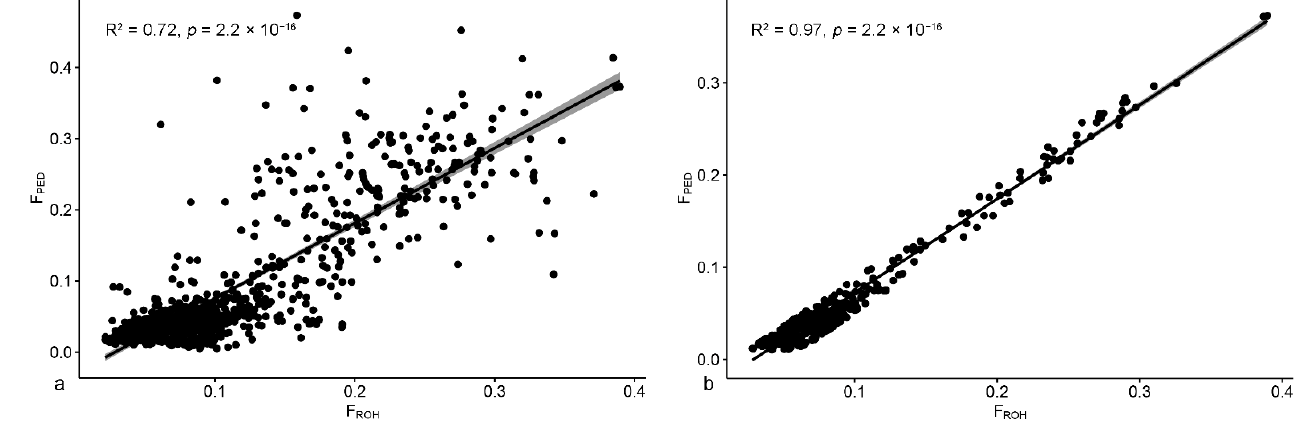
Figure 4. Linear regression models to estimate F PED from F ROH . ( a ) Linear regression model calcu- lated on all the animals with FullGen ≥ 6. ( b ) Refined model (removing animals falling below the 1st and above the 3rd quartile of the standardised residual distribution) for sheep with FullGen ≥ 6. The estimated F PED intervals and relative F ROH means and ranges for all the sheep with FullGen ≥ 6 are reported in Table 4. There was a significant difference in the breeds’ mean F ROH corresponding to an estimated F PED of 0.00–0.05 and 0.05–0.10: Comisana had the lowest F ROH values, followed by Massese, while Delle Langhe and Sarda present the highest values. As shown in Table 4, only Sarda animals were found in the higher F PED classes